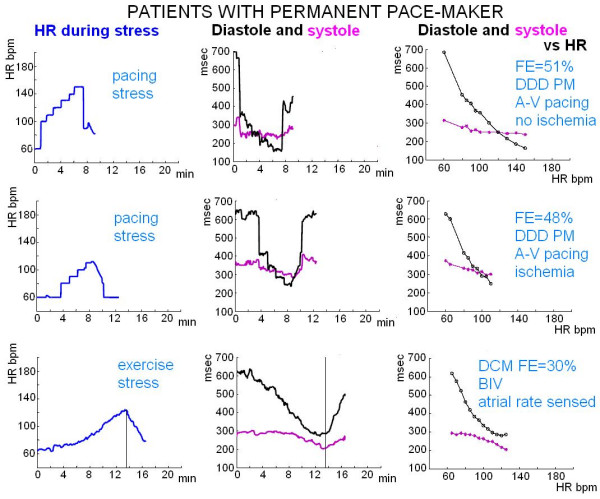
Patients with a permanent Pace Maker. Upper and middle panels, pacing stress echo: external programming of permanent PM induces a controlled change in heart rate which is independent of the patient capability to exercise; heart rate increase is achieved with sequential atrial-(right) ventricular stimulation with pacing induced left bundle branch block; a dramatic shortening of diastolic time occurs at pacing (from 60 bpm, spontaneous rhythmus to 100 bpm paced rhythmus) with a reversal of the systolic/diastolic ratio at 120 bpm heart rate). Lower panel, exercise stress in a patient with dilated cardiomyopathy (LVEF = 30%) and (sensed atrial rate) BIV pacing: the physiological induced increase in heart rate is accompanied by no reversal of the systolic/diastolic time ratio.